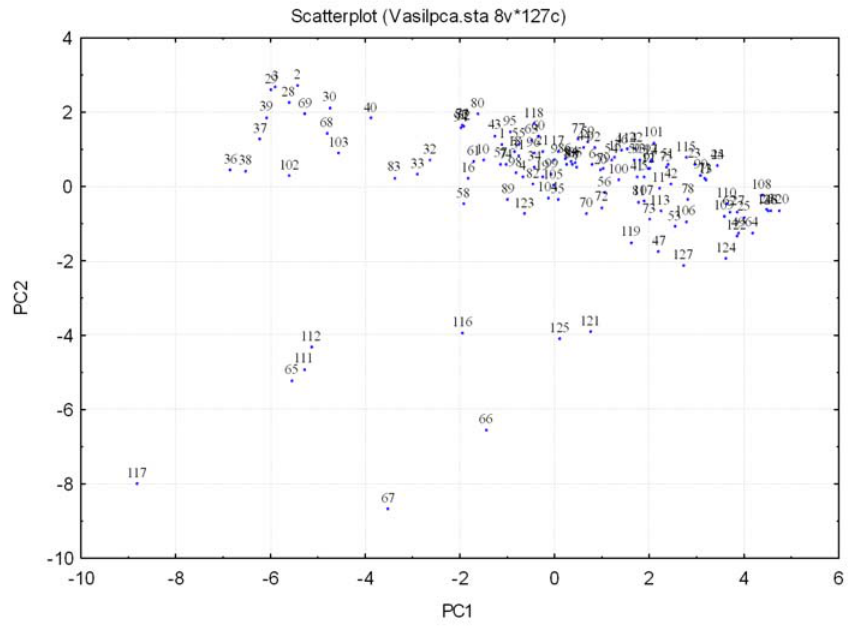
Fig. 4 Scatter plot of scores corresponding to the first two principal components (classical